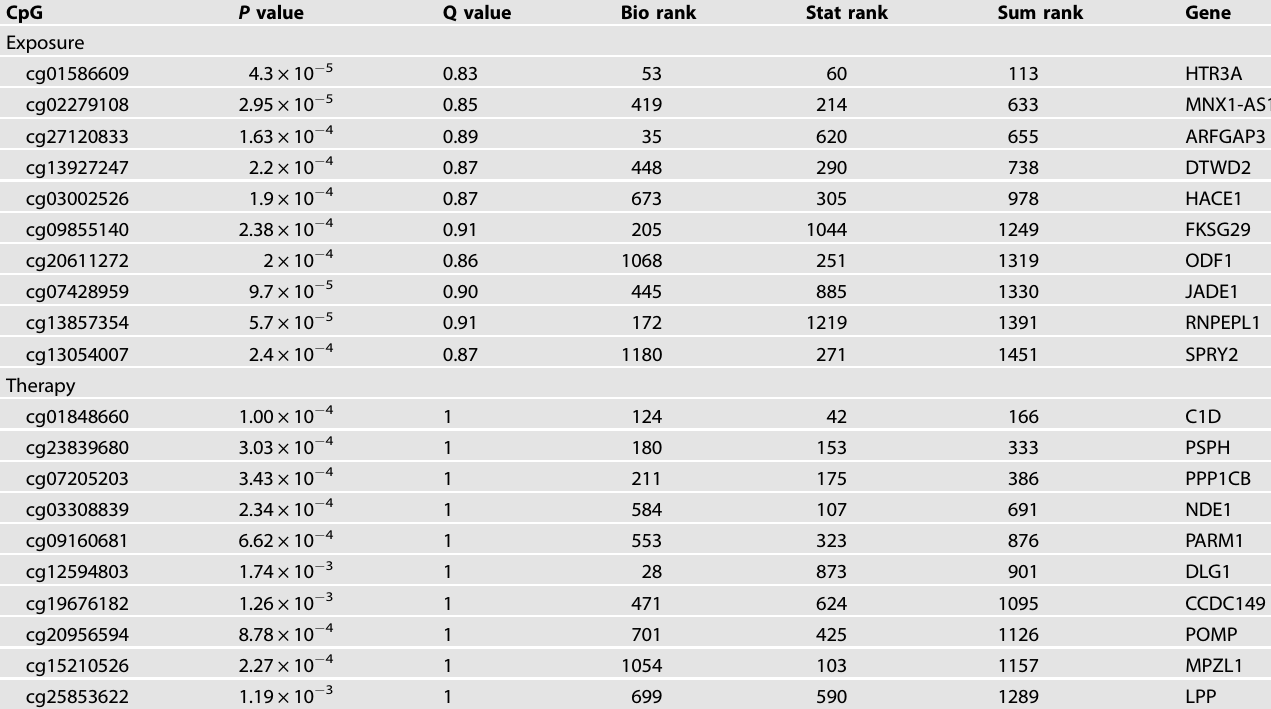
Table 2. Best-ranked CpGs for the exposure intervention and